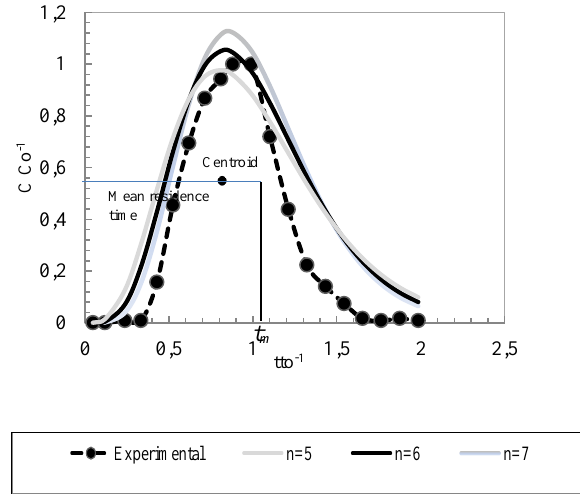
Figure 5. CMRS model for CF-UGF.